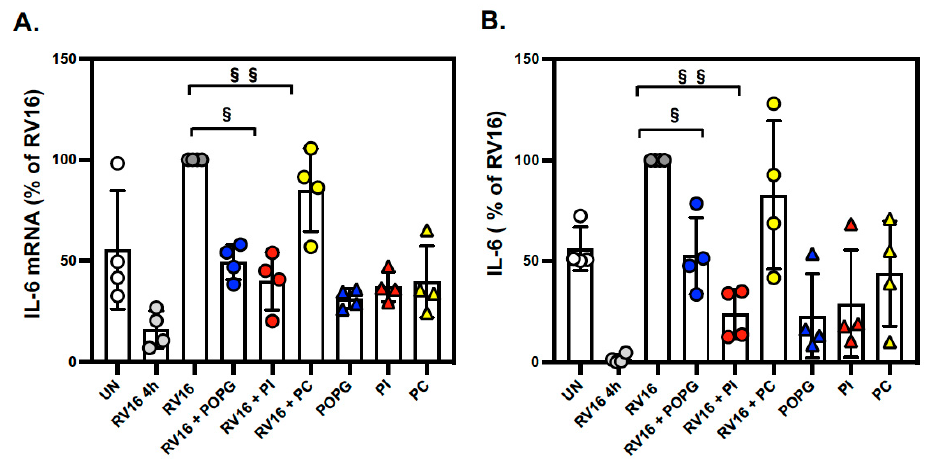
Figure 4. POPG and PI inhibit IL6 mRNA expression and protein secretion in RV-A16-infected AECs. The cells were treated with lipids and infected as in Figure 3. ( A ) IL6 mRNA expression and ( B ) IL-6 protein secretion induced by RV-A16 infection with or without lipid treatment. § indicates p < 0.01 and §§ indicates p < 0.001, respectively. The data are shown as mean ± SD from 3 independent experiments for each subject (subject numbers n = 4). Groups consisted of uninfected ( UN: white circle), viral binding and cell entry at 4 h ( RV16 4 h: gray circle), the virus alone at 48 h p.i. ( RV16: dark gray circle), the virus + POPG ( RV16 + POPG: bule circle), the virus + PI ( RV16 + PI: red circle), the virus + POPC ( RV16 + PC: yellow circle), and lipids alone ( POPG: blue triangle, PI: red triangle, and PC: yellow